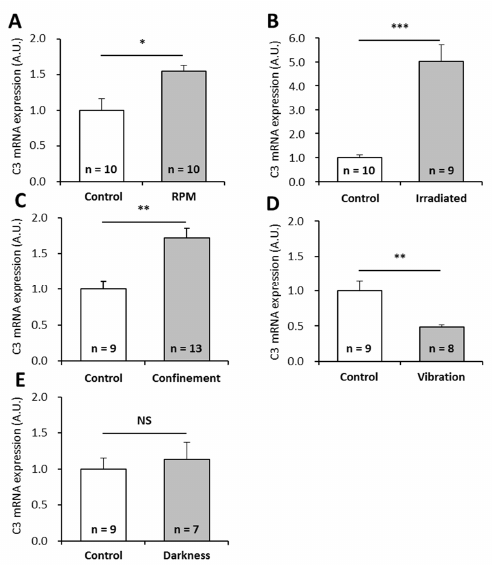
Figure 2. Effects of individual stressors, similar to those encountered during a stay in the ISS, on P. waltl complement C3 mRNA levels. Complement C3 mRNAs were quantified by RT-qPCR in larvae subjected to ( A ) simulated microgravity, ( B ) simulated ISS radiation environment, ( C ) confinement, ( D ) vibration, or ( E ) obscurity. Relative values obtained with unstressed controls were set to 1. Results are expressed as means ± SEM. “A.U.” stands for “arbitrary units”. Differences were found using Student’s t -tests or Mann—Whitney tests. * p < 0.05, ** p < 0.01, *** p < 0.001, NS., no statistical difference.